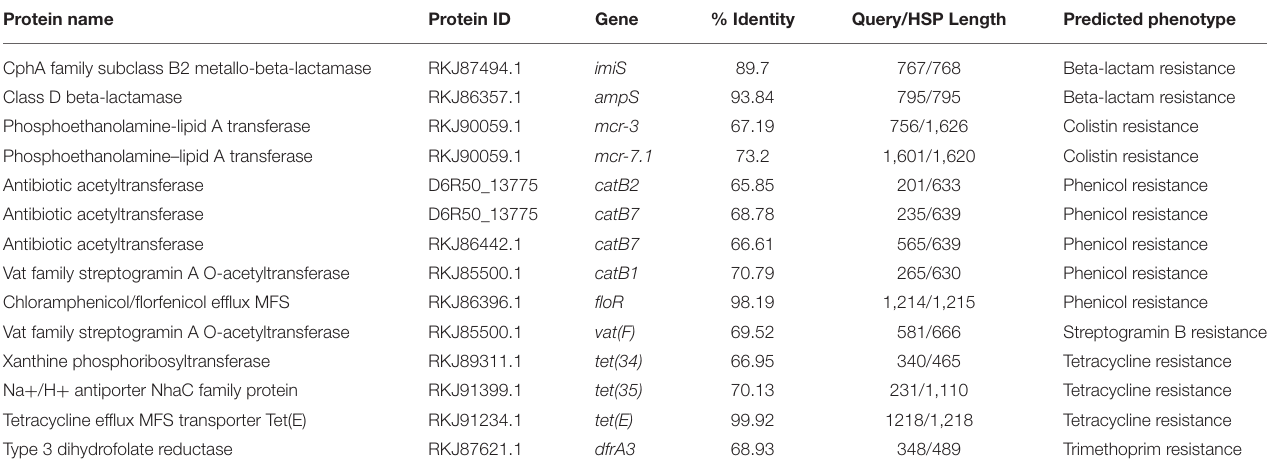
TABLE 2 | Predicted antibiotic resistance genes in A. veronii strain